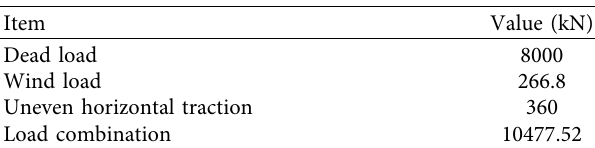
Figure 16: Overall assembly jig for the steel cylinders: (a) 3D model; (b) top view; (c) side view. Table 6: Load combinations.